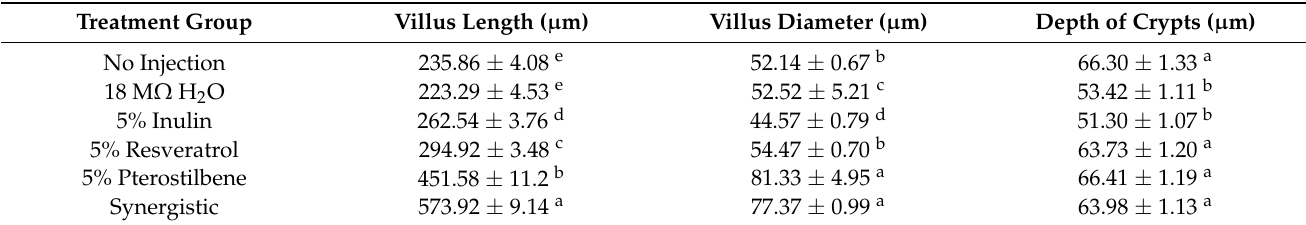
Table 4. Effect of the intra-amniotic administration of stilbenes on the duodenal small intestinal villi length, villi diameter and crypt depth.